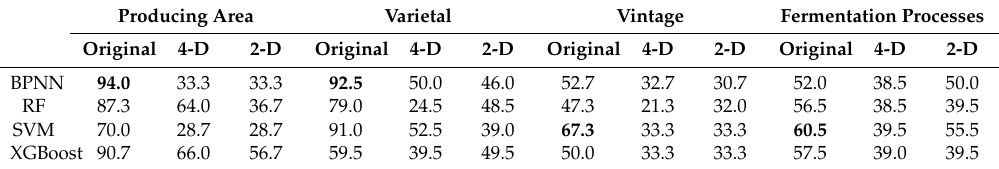
Bold values indicate the best